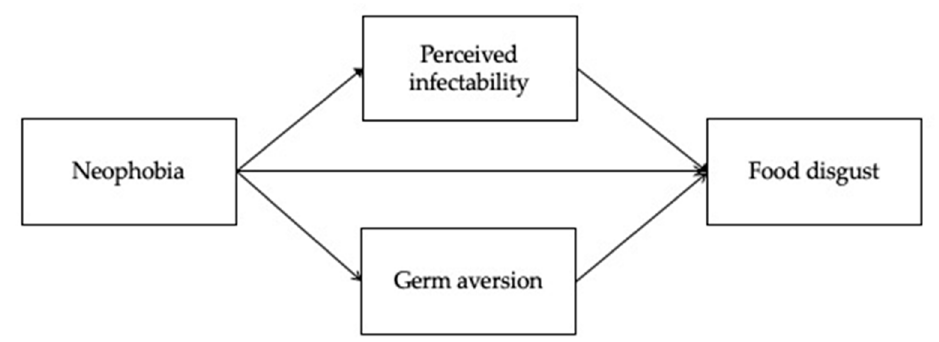
Figure 1. The hypothesized model.